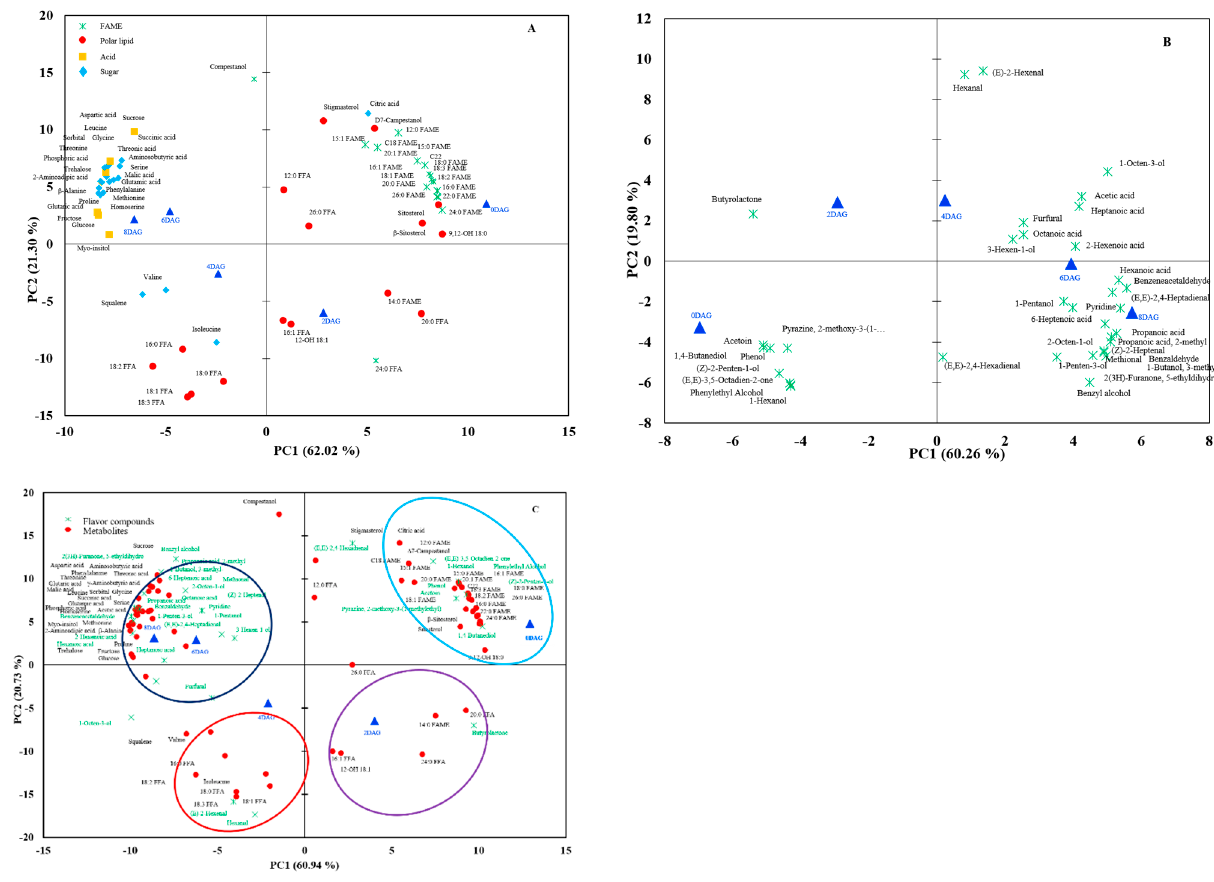
Figure 2. Biplot of principal component analysis from metabolites ( A ), flavor compounds ( B ), and metabolites and flavor compounds ( C ) in sacha inchi seeds at different germination times ( p ≤ 0.05). FAME, fatty acid methyl ester; FFA, free fatty acid; DAG, days after germination.